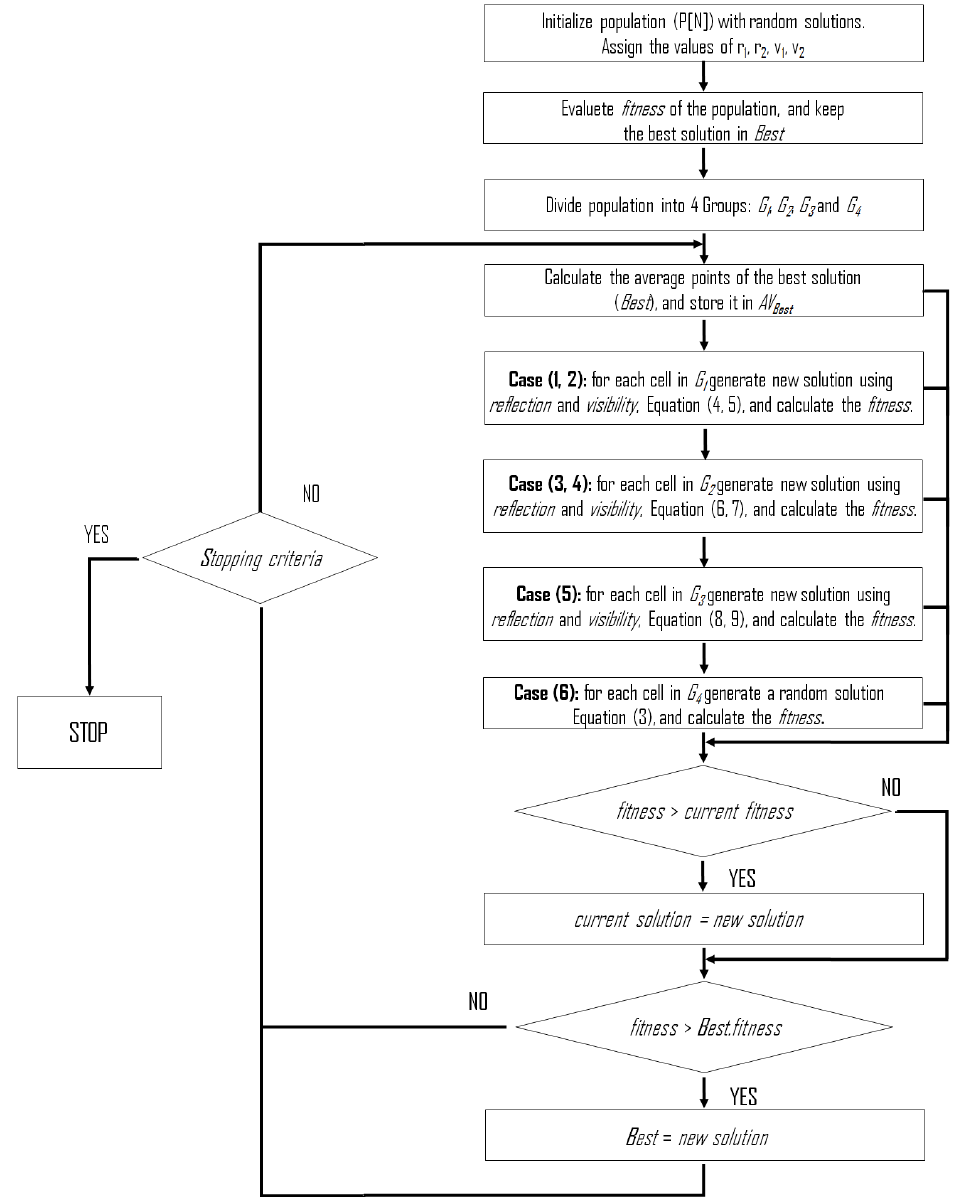
Figure 6. The CFA algorithm